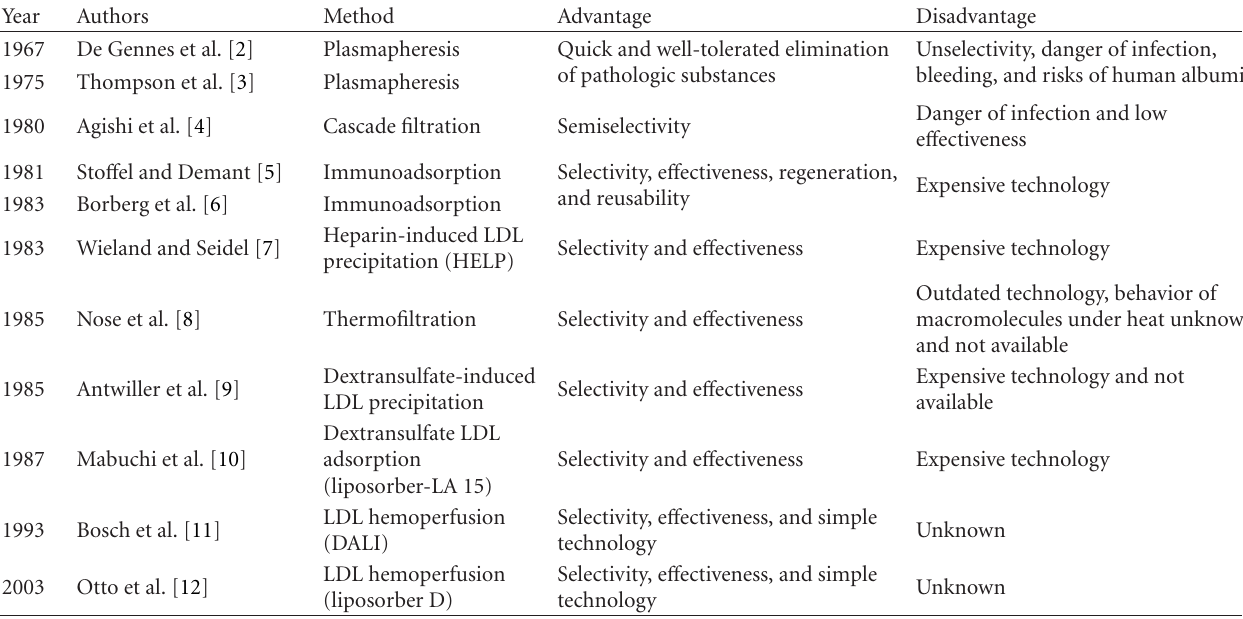
Table 1: Extracorporeal methods for elimination of LDL cholesterol [1].